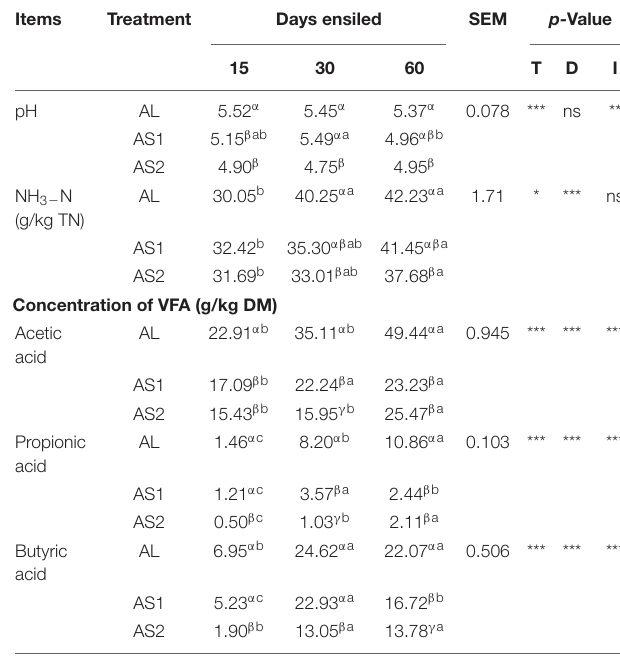
3 − N, ammonia nitrogen; TN, total nitrogen; T, treatments; D, ensiling duration; I, interaction between ensiling duration and treatments; SEM, standard error of means; VFA, volatile fatty acid. a , b , c Means within a row with different superscripts differ (p < 0.05). α,β,γ Means within a column with different superscripts differ (p < 0.05). *p < 0.05; **p < 0.01; ***p < 0.001; and ns, not significant.